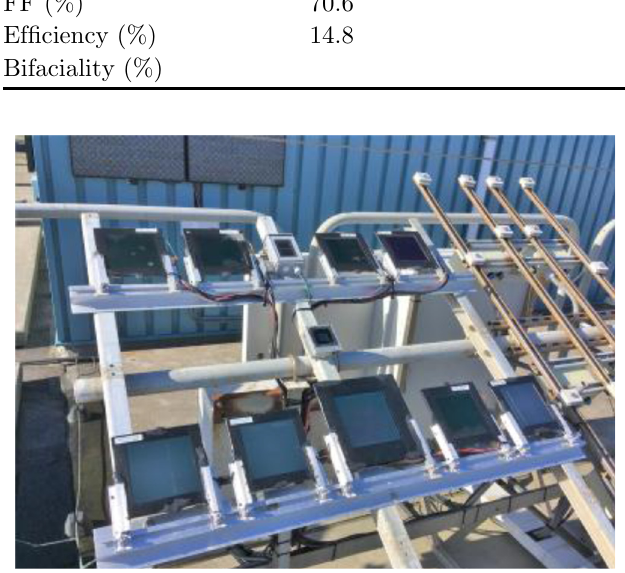
Fig. 3. Photograph of outdoor facility. Top row was assigned to this